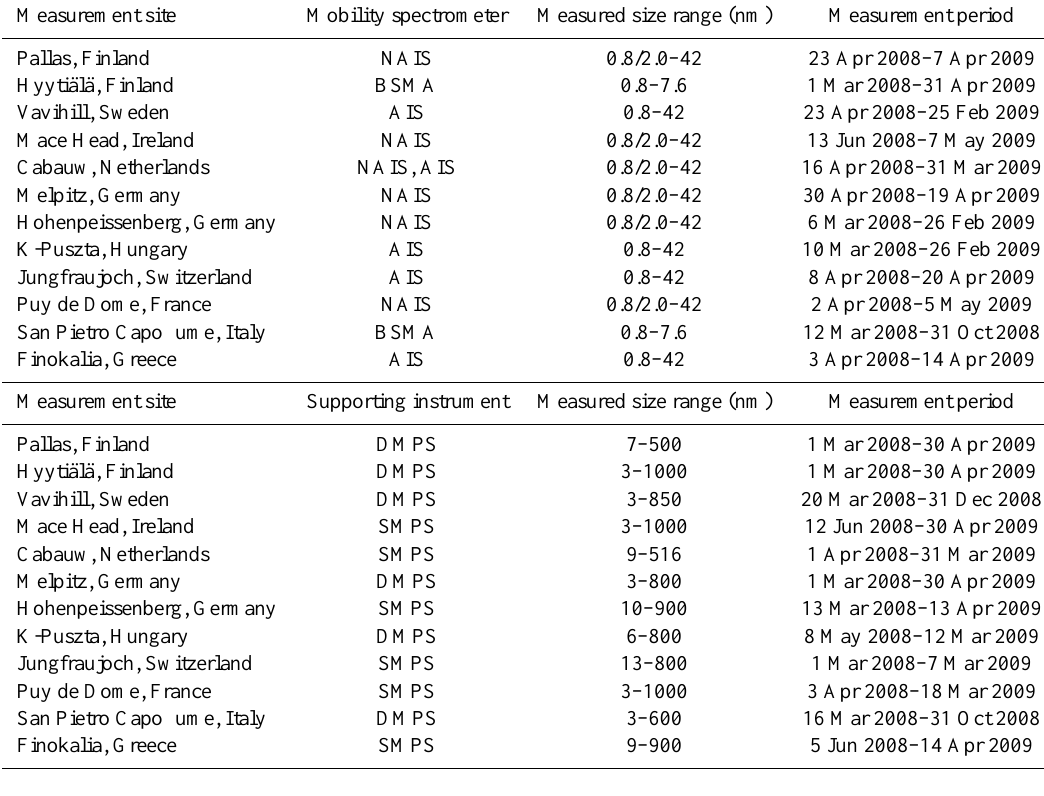
Table 2. Aerosol instrumentation, measuring range and the measurement period during the EUCAARI project at each measurement site. The AIS and the BSMA measured ion number size distributions, whereas the NAIS measured both ion and total particle number size distributions. Supporting aerosol instrumentation – the DMPS and the SMPS – measured total particle number size distributions.